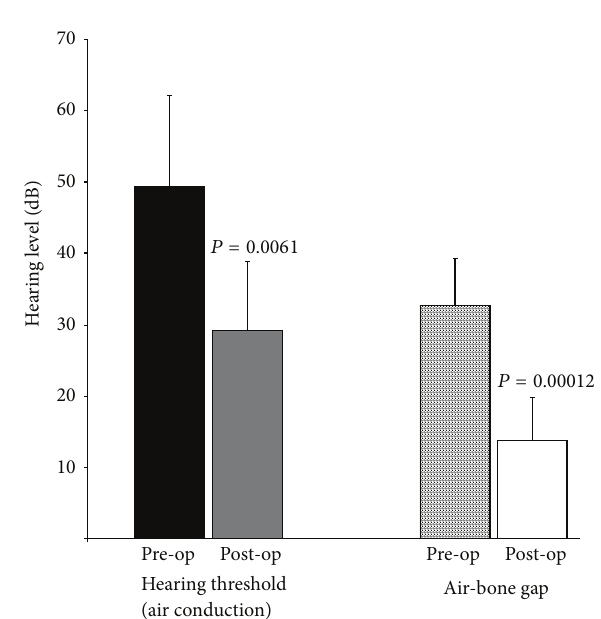
Figure 1: Hearing thresholds before and after surgery. Preoperative (pre-op) and postoperative (post-op) hearing thresholds in db Hearing Level including standard deviation are shown. The first group of two columns (black and grey column, resp.) denotes the hearing threshold on air conduction preoperatively and postopera- tively. The second group of two columns denotes the air-bone gap preoperatively and postoperatively (patterned and white column,